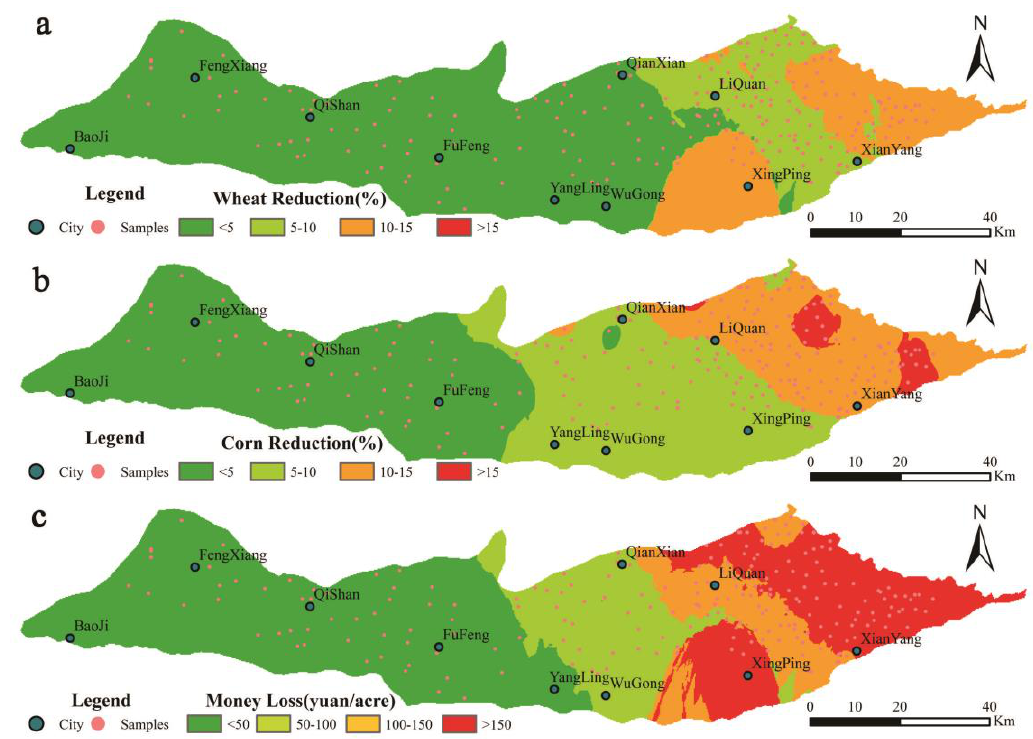
Figure 5. Spatial Variation map of Wheat Reduction ( a ), Corn Reduction ( b ) and Money Loss ( c ).